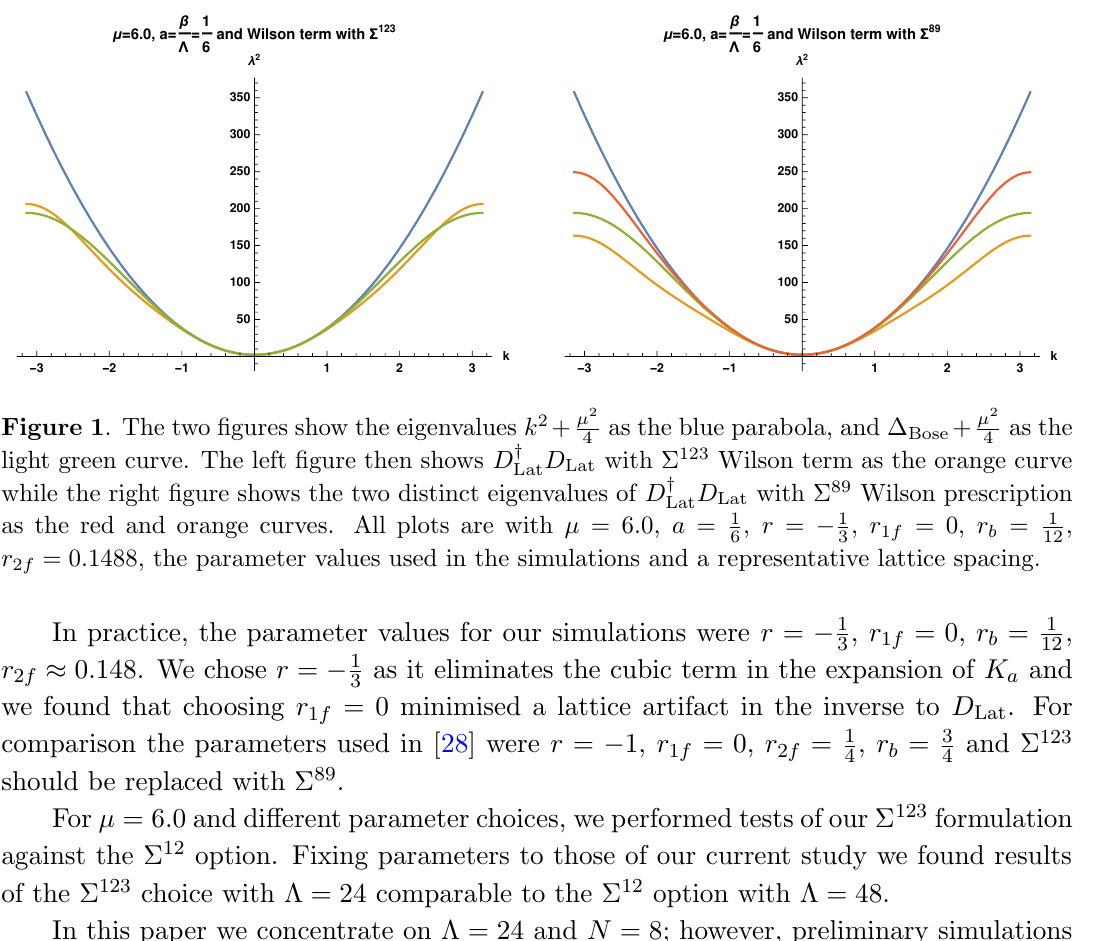
as it eliminates the cubic term in the expansion of K 3